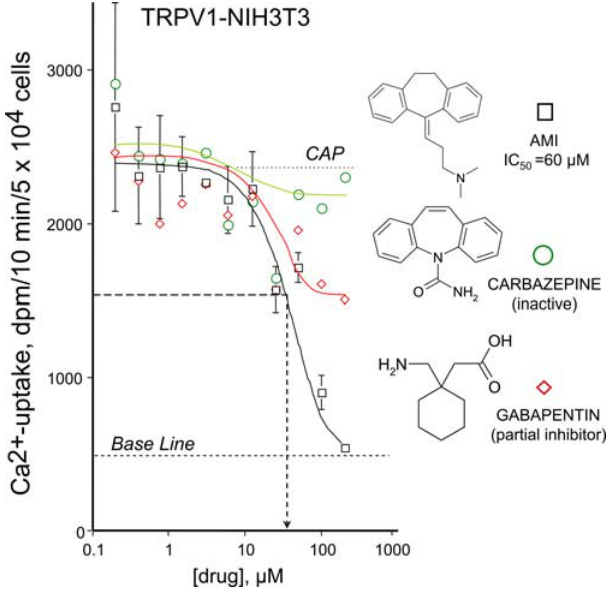
Figure 5. Activity of other drugs, similar to chlorpromazine and trifluoperazine, on TRPV1. Amitriptyline (AMI), carbamazepine and gabapentine were tried in cell based capsaicin-induced Ca 2 + -uptake experiments. Among these substances amitriptyline, a tricyclic ana- logue of phenothiazines, was the best inhibitor, however, carbamaze- pine with shorter side chain than amitriptyline was determined inactive. Gabapentine showed only partial inhibition on TRPV1. Similar results were obtained in two additional experiments carried out in triplicate. Figure 4. Effect of a non-membrane permeable inhibitor of